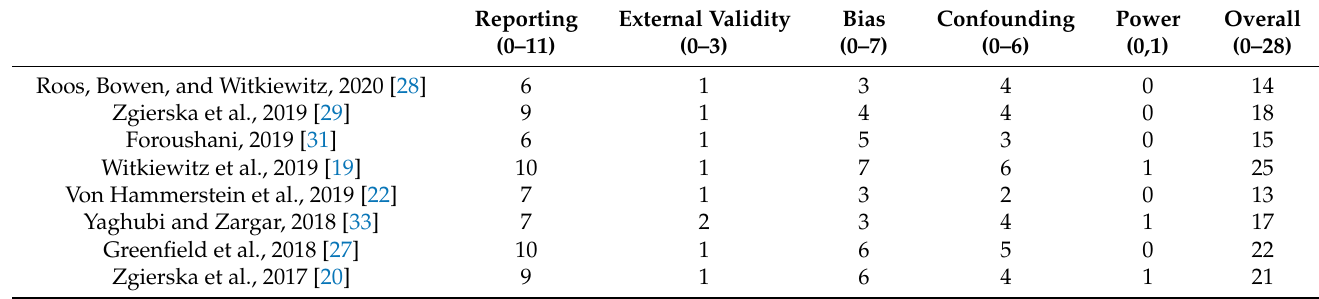
Table A3. Methodological quality of the included